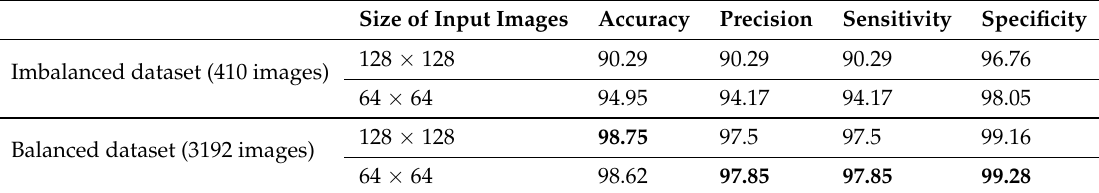
Table 6. Accuracy, Precision, Sensitivity and Specificity of CNN-based classification method on